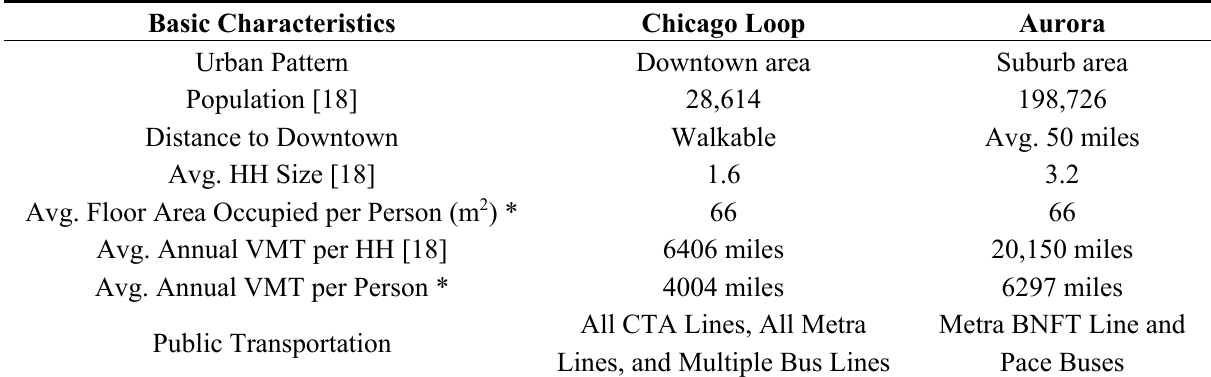
Figure 2. Urban layouts of typical residential communities in the ( a ) downtown Chicago Loop and ( b ) suburban Aurora. Table 1. Basic characteristics of the two study